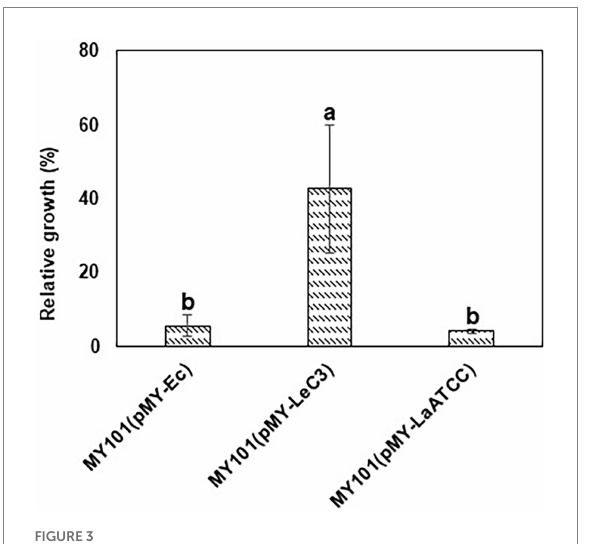
FIGURE 3 16S rRNA from LeC3 conferred resistance to spectinomycin (Spc) as compared with 16S rRNA from LaATCC29479 in Escherichia coli strain MY101. Relative growth was calculated as the ratio of growth (OD 600 ) with 64 µ g/ml Spc to bacterial growth without Spc 24 h after inoculation. Error bars represented SD. Different letters indicated significant differences from one-way ANOVA followed by Fisher’s LSD test ( p < 0.05).